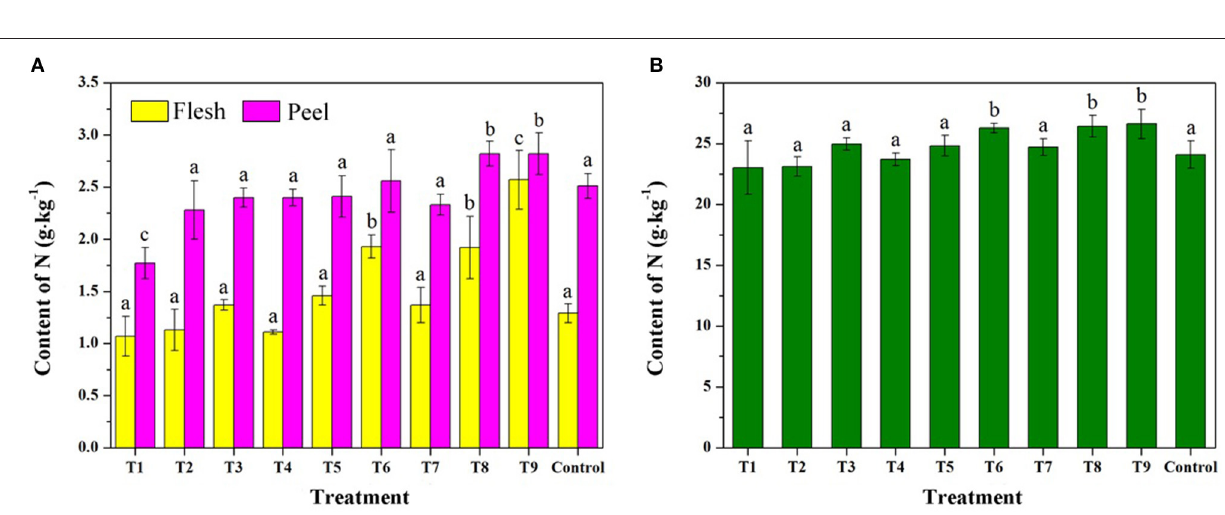
FIGURE 9 | Effects of MRPs–Ca/Fe/Zn on N contents of fleshes (A) , peels (A) , and leaves (B)